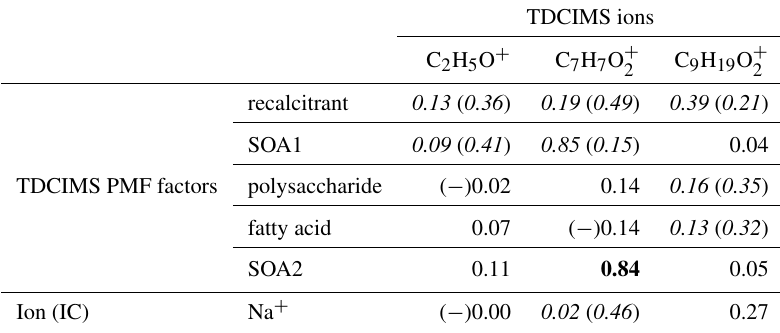
Table 4. Coefficients of determination ( r 2 s) for relationships between selected TDCIMS ions (previously linked to marine aerosol in Lawler et al., 2014), TDCIMS-derived PMF factors, and two Na + measurements for ambient submicron (PM1) aerosol. Bold text indicates a strong statistical relationship, with a linear slope 4 standard deviations greater than 0. Underlined text indicates a modest relationship, with a linear slope 2 standard deviations greater than 0. Cases for which removing a single point changes a relationship between none and modest or none and strong are shown as “with (without)” that point and italicized. Relationships for which r is negative are indicated with ( −